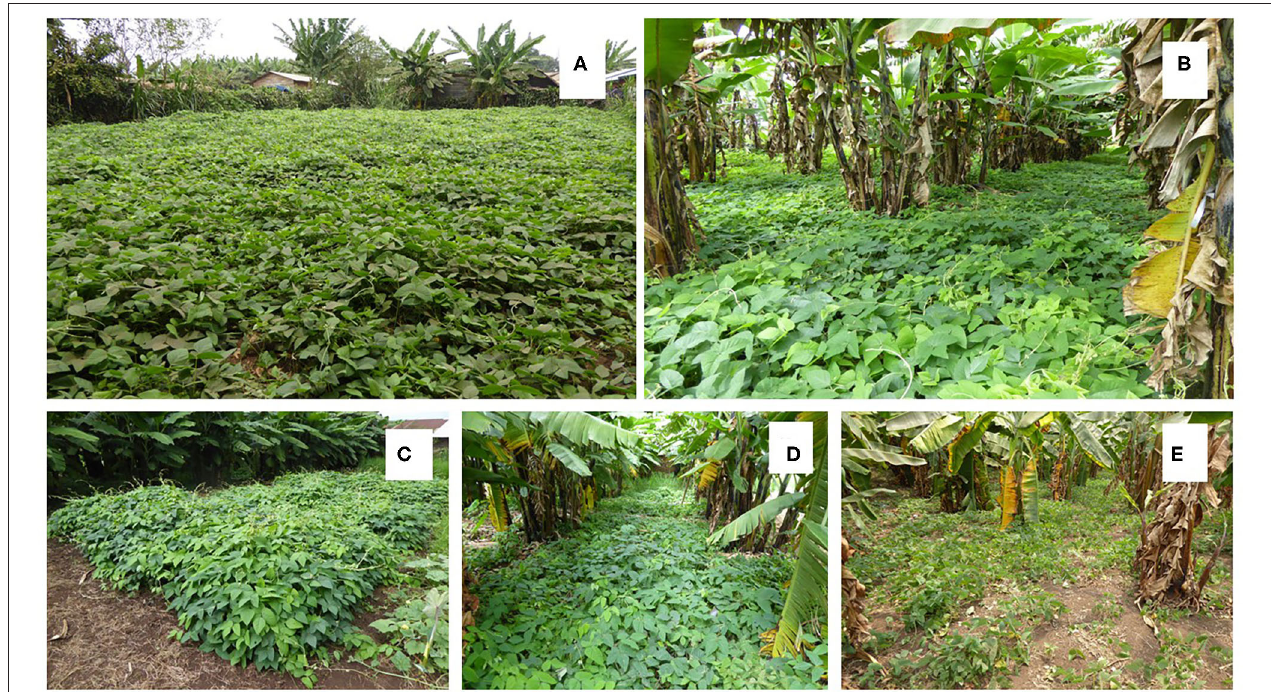
FIGURE 3 | Mucuna grown as a monocrop (A,C) and as an intercrop under 3 × 4m spaced banana fields (B,D,E) . Mucuna monocrop (A) was planted in May 2016 (at the end of season B and start of the long dry season) (photo was taken in the dry season, in August 2016) while monocrop (C) was planted in December 2016 at the onset of the short dry season and extended over cropping season B (photo was taken in the rainy season, in April 2017). Mucuna intercrop in (B) was planted in early March 2016 at the onset of the rainy season B (photo taken in the rainy season in April); intercrop in (D) was planted at the start of the short dry season (December 2016) and extended over cropping season B (photo was taken in the rainy season, in April 2017); and (E) a mucuna intercrop planted at the onset of the long dry season in May 2016 (photo was taken at the end of the long dry season in August 2016). Rainy season B stretches from start of March to end of May, the long dry season from end of May/ start of June to end of August and the short dry season from end of December to end of February. Photos (A,E) were taken at the Katana site, (C,D) at the Kavumu site, while (B) was taken at the INERA-Mulungu